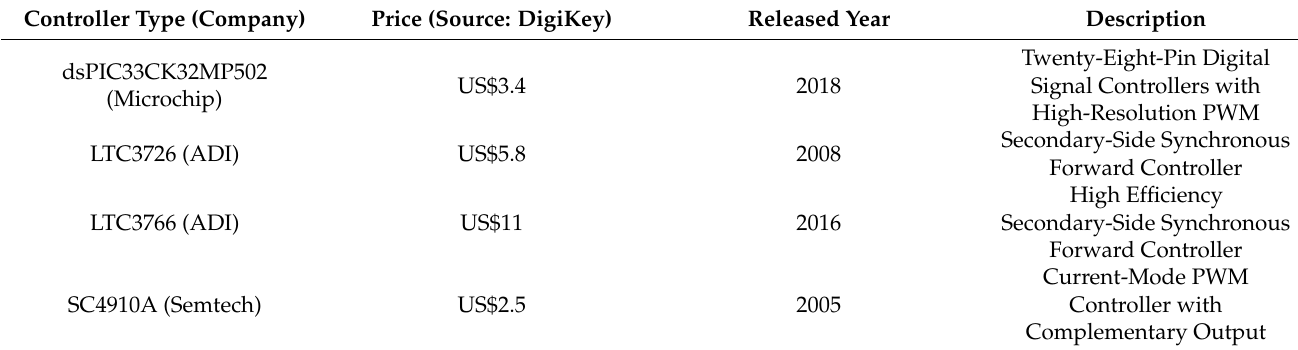
Table 1. Comparison with other SR forward